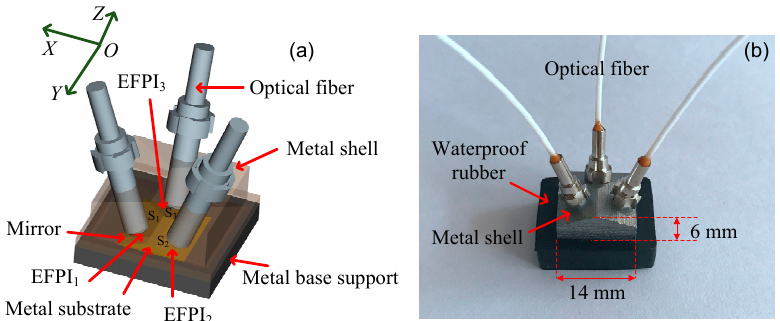
Figure 2. ( a ) Three-dimensional rendering of the triaxial sensor model for 3D relative displacement sensing. The mirrors and endfaces of the corresponding optical fibers are parallel, such that three EFPIs are formed. Both the optical fibers and mirrors are supported on separate roof-like